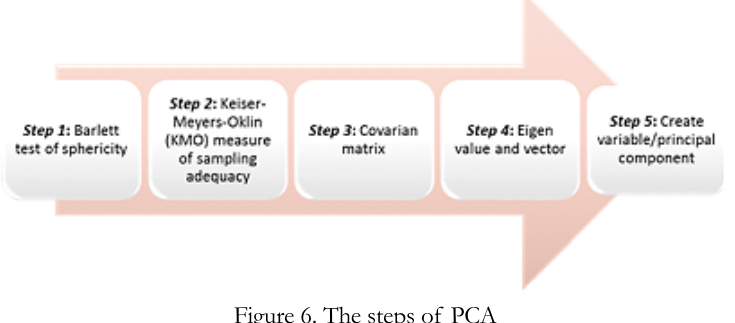
Figure 6. The steps of